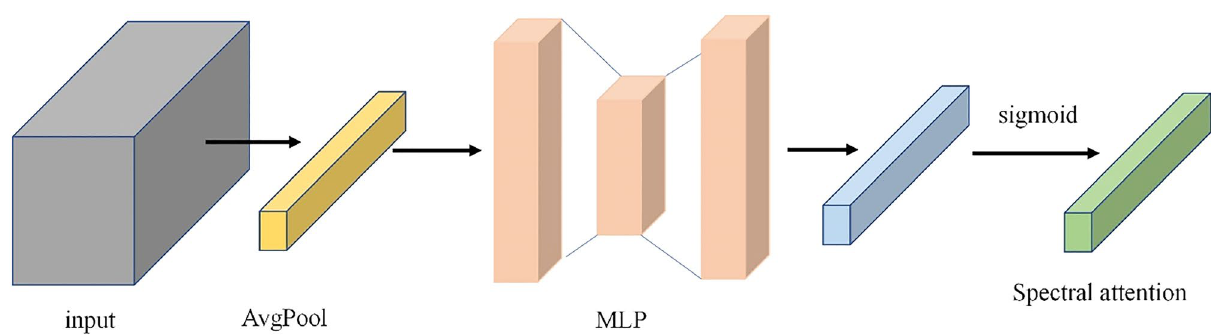
Figure 4. Generate spectral attention. This module contains a global average pooling and a multilayer perceptron (MLP) consisting of two fully connected